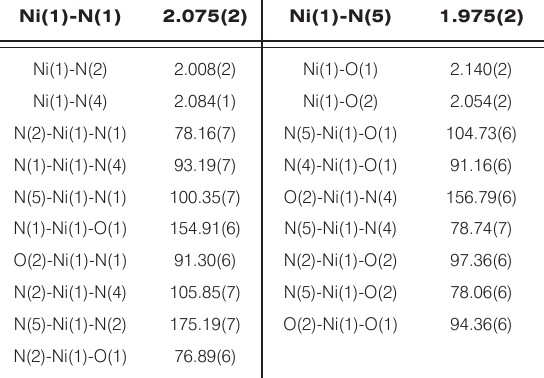
Table 3. Selected bond lengths [Å] and angles [ o ] for 2